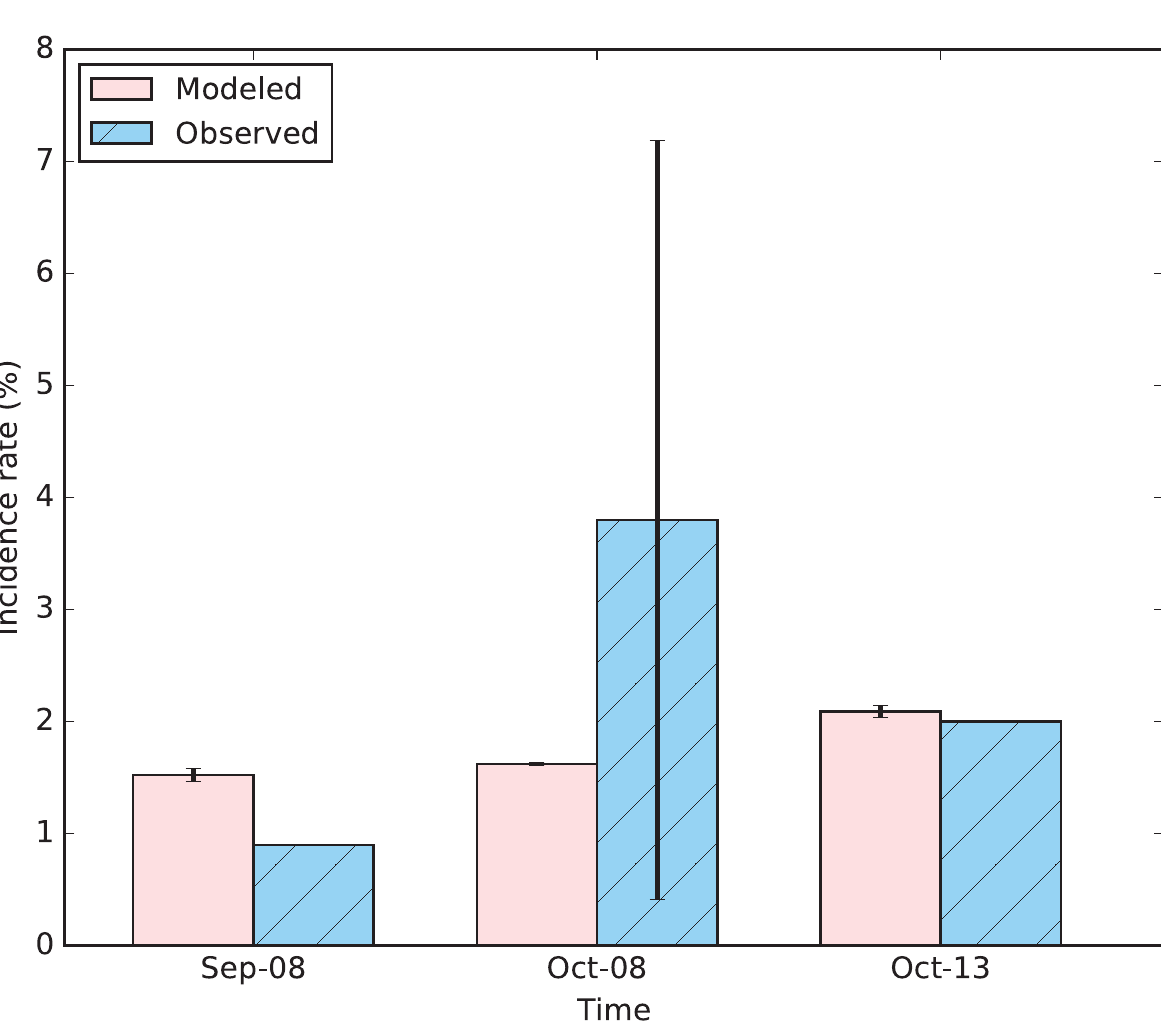
Fig 5. Comparison of malaria incidence rate modeled by SLIM and observed data. Vertical line represents ± standard deviation. Malaria incidence data are collected in 3 elementary schools in the area and from the Malaria Atlas Project. The high uncertainty of observed incidence in Oct 2008 comes from the variability and small sample size of the data